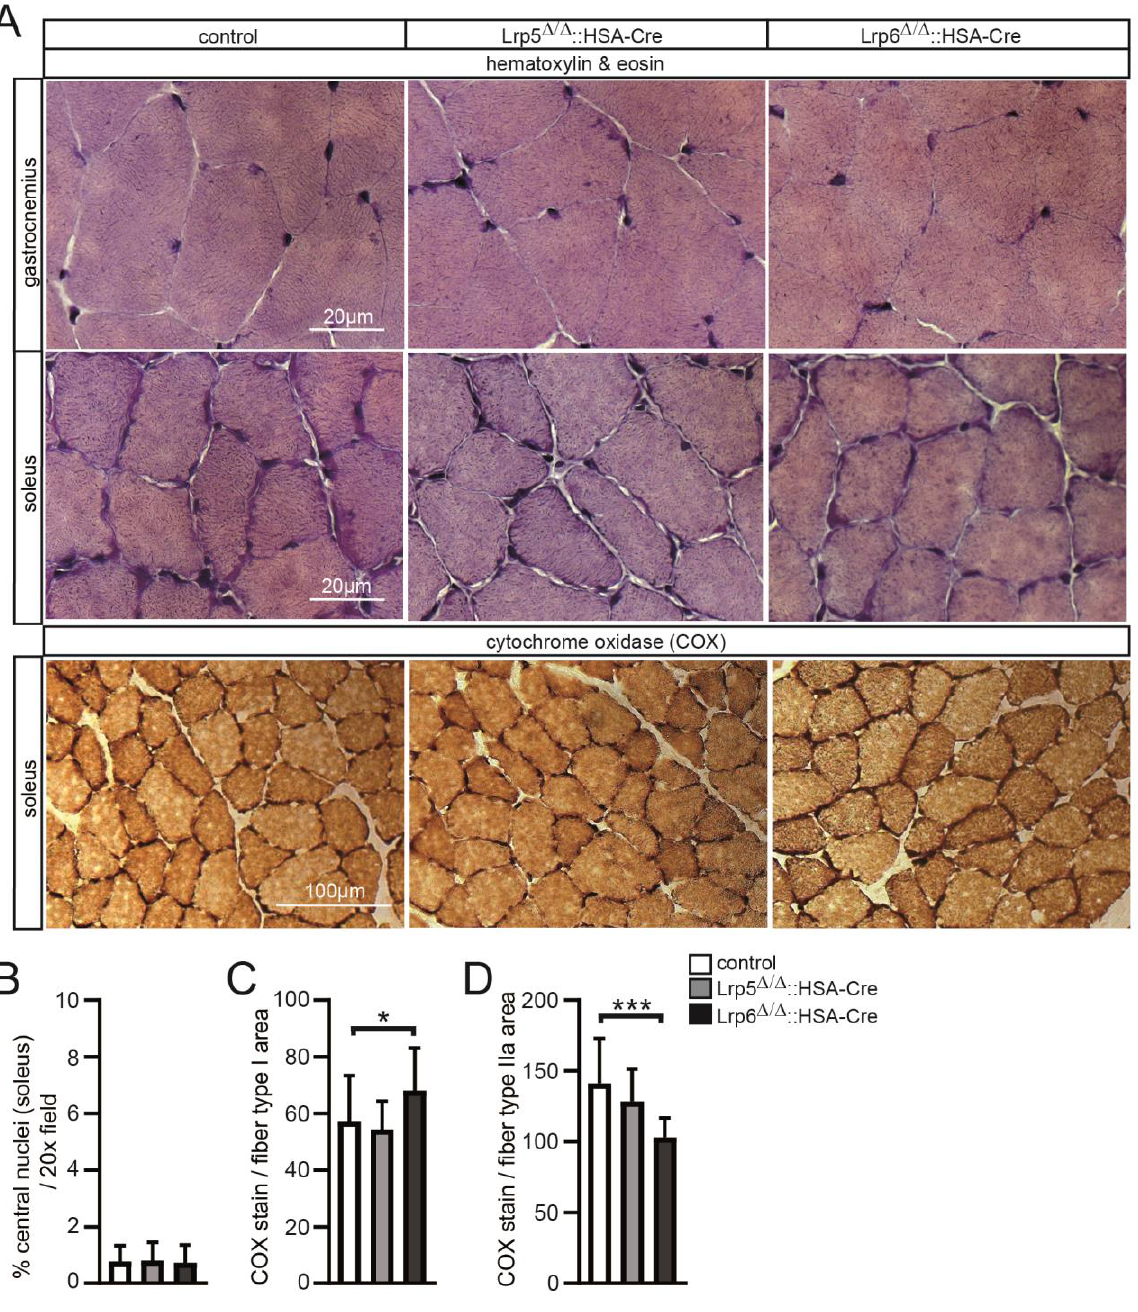
Figure 2. Reduced oxidative metabolism in type IIa fibers of conditional Lrp5 or Lrp6 knockout muscles. ( A ) Upper part, hematoxylin and eosin stain of hind limb muscle cross sections of control and conditional Lrp5 or Lrp6 knockout mice did not reveal any apparent changes. Lower part, Cox stain of soleus muscles with same genotypes as depicted in ( A ). ( B ) Graph presents number of